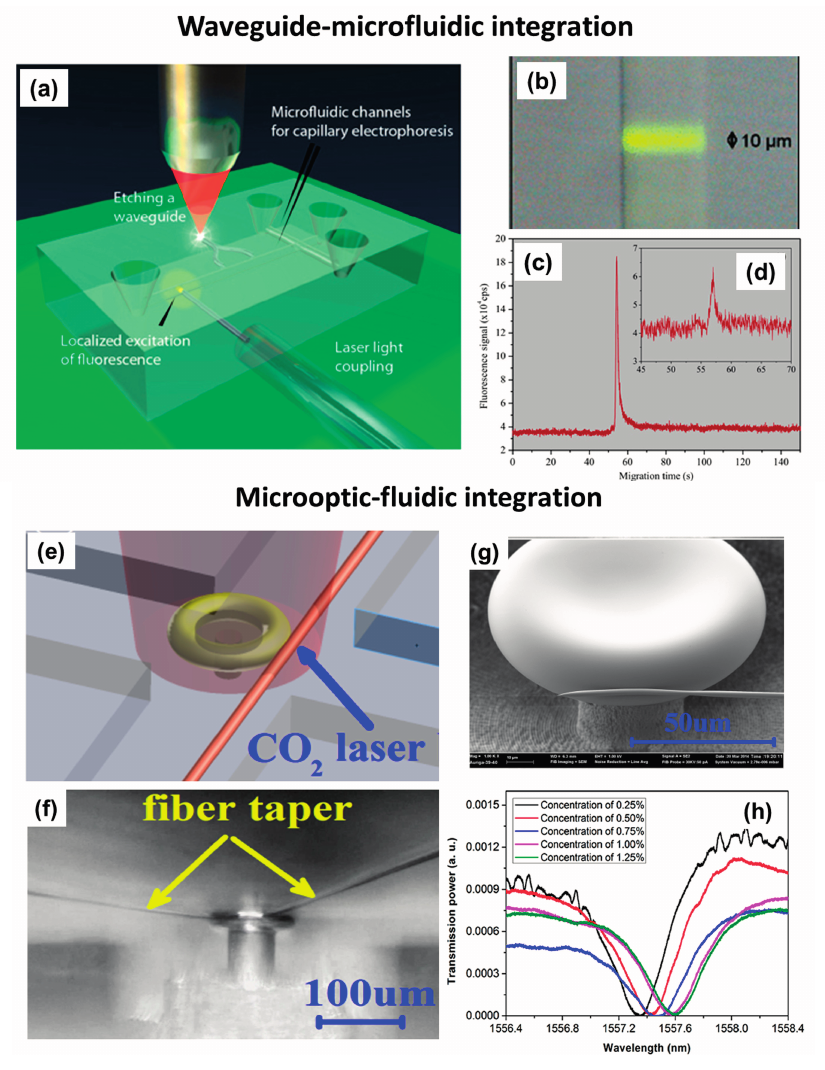
Figure 12c and d show electropherograms corresponding to concentrations of 1 and 10 nM of a Cy3-labelled 23-mer oligonucleotide, respectively, which illustrate the high sensitivity of the device. Figure 12. Waveguide-microfluidic integration and microoptic-fluidic integration using FsLDW, respectively. ( a ) Schematic illustration of FsLDW method used for adding optical waveguides to a lab-on-a-chip device for capillary electrophoresis; ( b ) Optical micrograph of the fluorescence signal excited in the microchannel by the optical